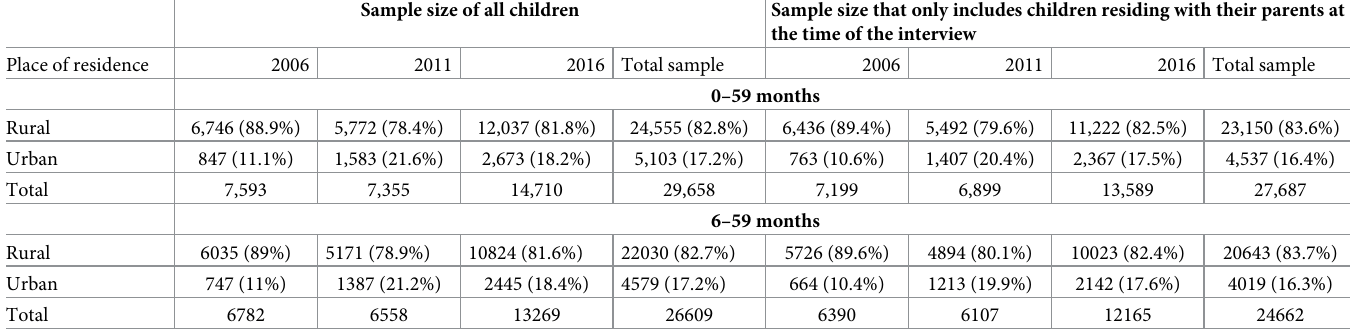
Table 1. Distribution of unweighted sample size across years of data collection. Sample size of all